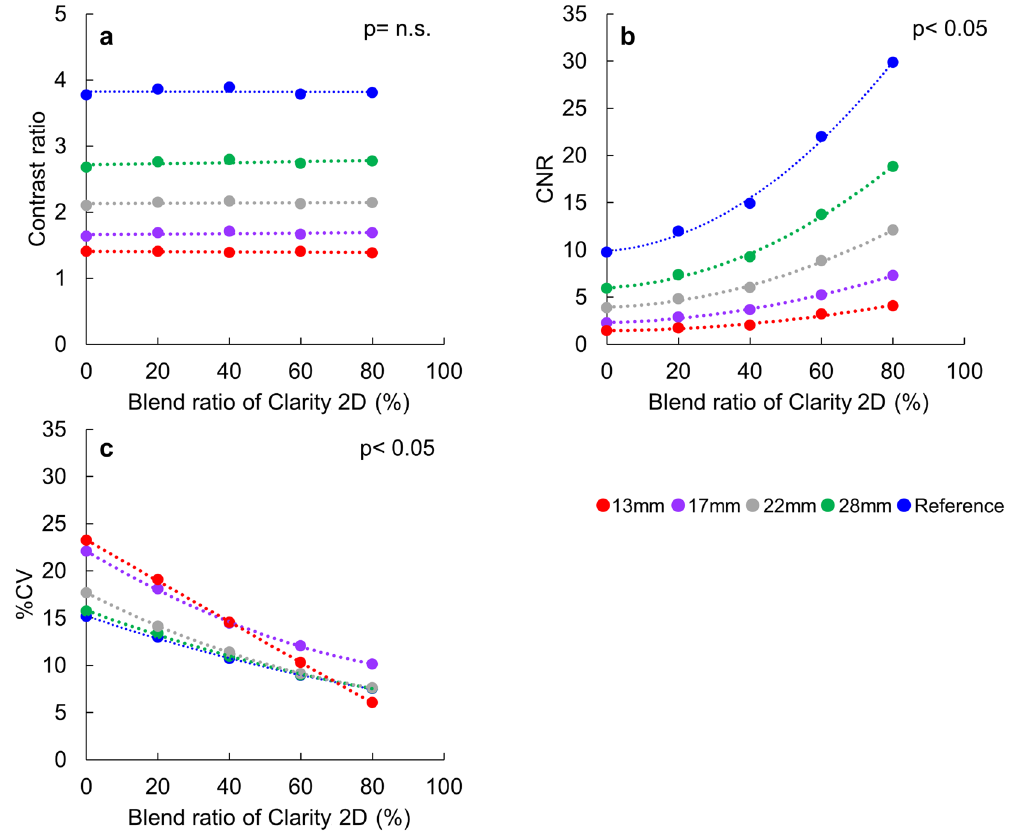
Figure 3. Quantitative evaluation of different blend ratios for Clarity 2D processing in the SwiftScan planar image. ( a ) Contrast ratio, ( b ) Contrast to noise ratio (CNR), and ( c ) the percent of the coefficient of variance (%